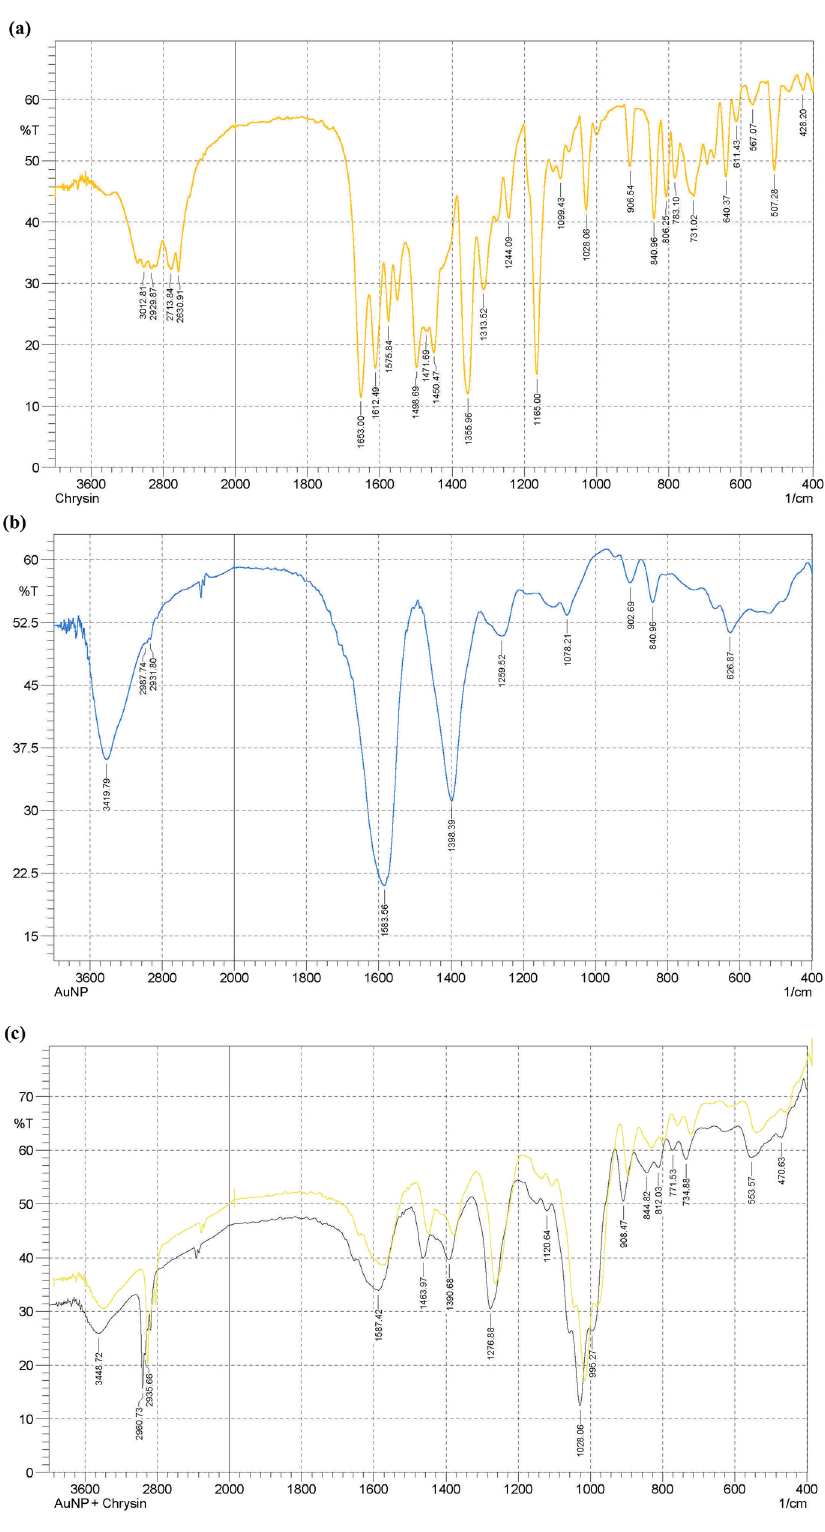
Figure 4: FT - IR spectroscopic analyses: ( a ) CHR, ( b ) AuNPs, and ( c ) CHR –